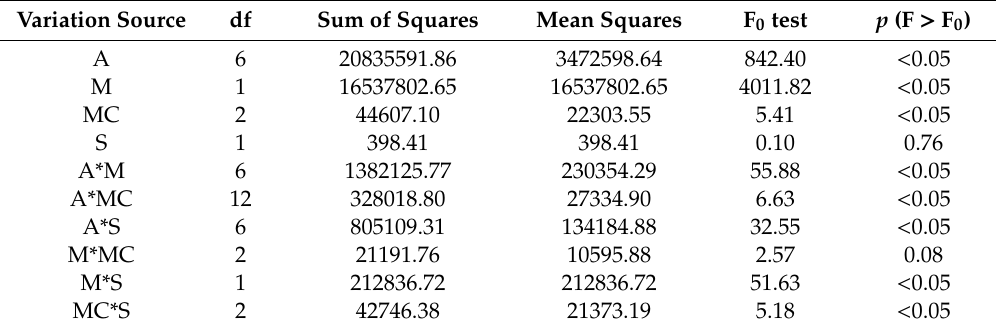
Table 4. Statistical analysis of the e ff ect of variation source and its interactions on the cutting force (CF) of starch-based